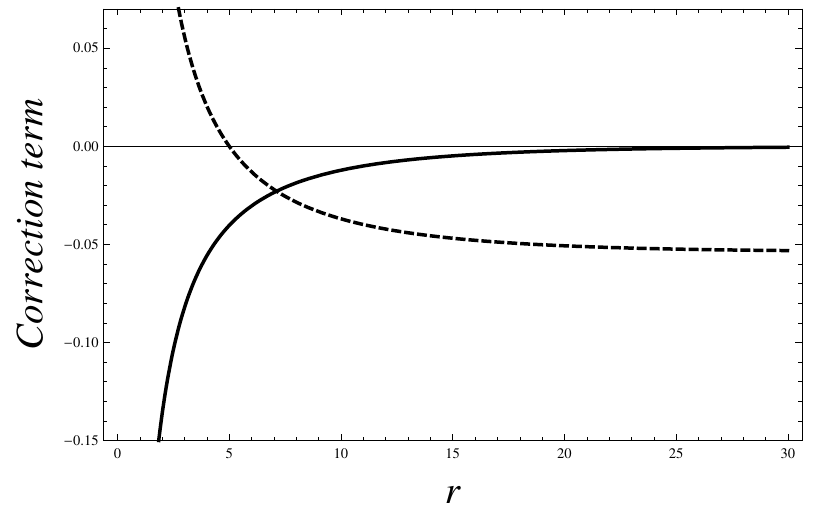
Figure 10. Comparison between the corrective terms induced by f ( R ) -gravity ( − e − µ 1 r = 0 . 1 , β = 0 . 8 and r , dashed line). µ solid line) and R n -gravity ( 1 − ( r/r c ) β 1 2 r unities for r and µ are arbitrary. The dashed curve shows a very slow c 1